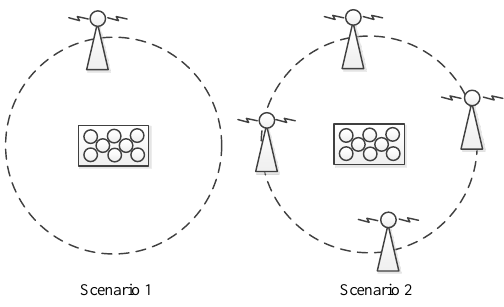
Figure 17. The two jamming scenarios used in the following experiments. Table 5. Information of the 4 jammers in Scenario 2.